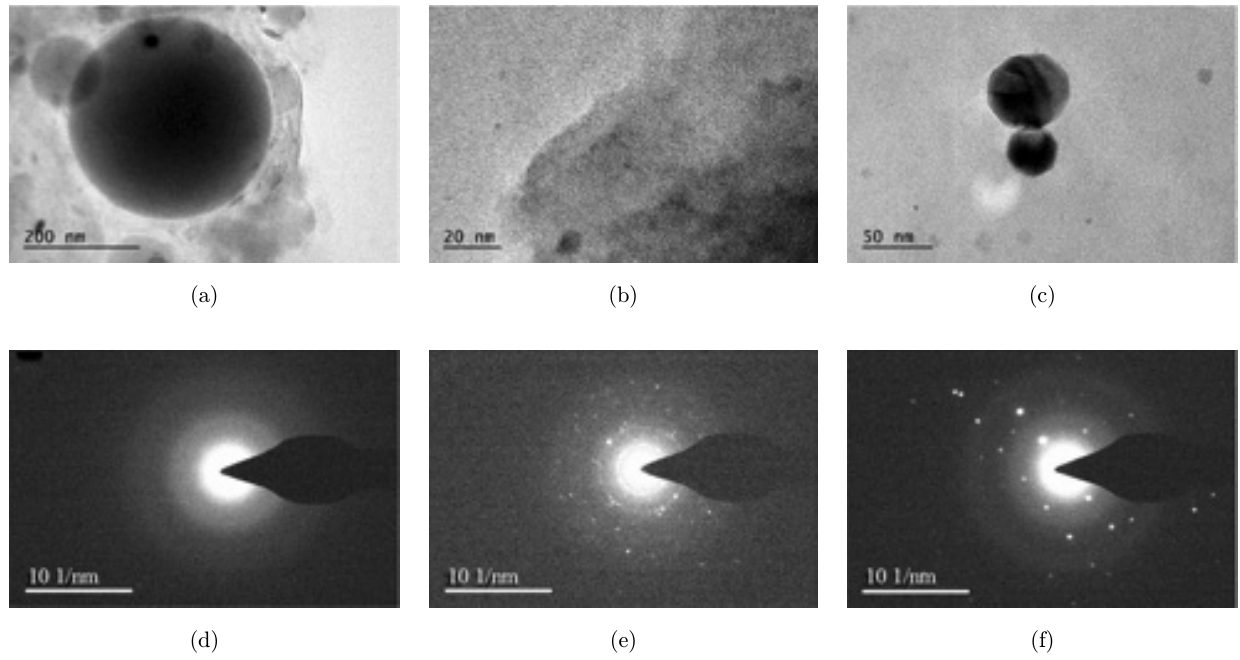
Fig. 3. TEM images of (a) CS nanoparticles, (b) EGCG (c) CS-EGCG nanoparticles and the SEAD image of (d) CS nanoparticles, (e) EGCG and (f) CS-EGCG nanoparticles.